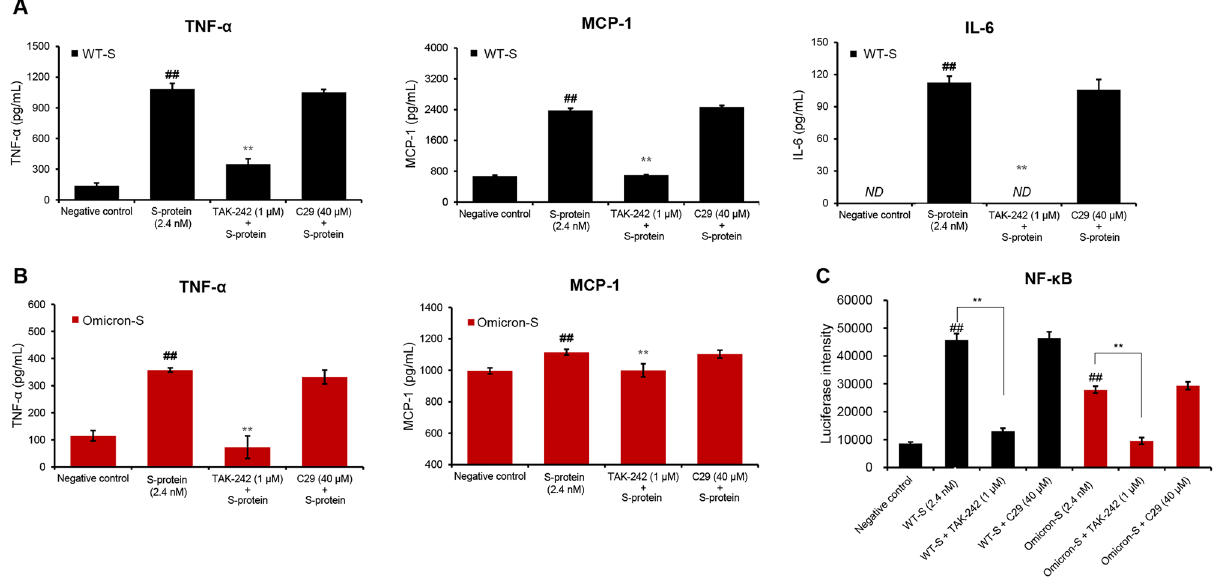
Figure 3. Effects of TAK-242 and C29 on the pro-inflammatory reactions induced by two trimer S-proteins. ( A–B ) Effects of TAK-242 and C29 on supernatant TNF-α, MCP-1 and IL-6 induced by WT-S ( A ) or Omicron-S ( B ) in RAW264.7 macrophages. The cells were treated with trimer WT-S or Omicron-S (2.4 nM) in the presence of TAK-242 (1 μM) or C29 (40 μM). Twenty-four hours later, supernatant TNF-α, MCP-1 and IL-6 were determined. ND , not detected. ( C ) Effects of TAK-242 and C29 on trimer WT-S- or Omicron-S-induced NF-κB activation. RAW264.7 cells stably transfected with NF-κB-TA-luc plasmid were treated with C29 (40 μM) or TAK-242 (1 μM) and then stimulated by trimer WT-S or Omicron-S (2.4 nM). Four hours later, the luciferase activities were detected. Mean ± SD (n = 3). ## P < 0.01 vs . negative control; ** P < 0.01 vs . WT-S or Omicron-S alone.